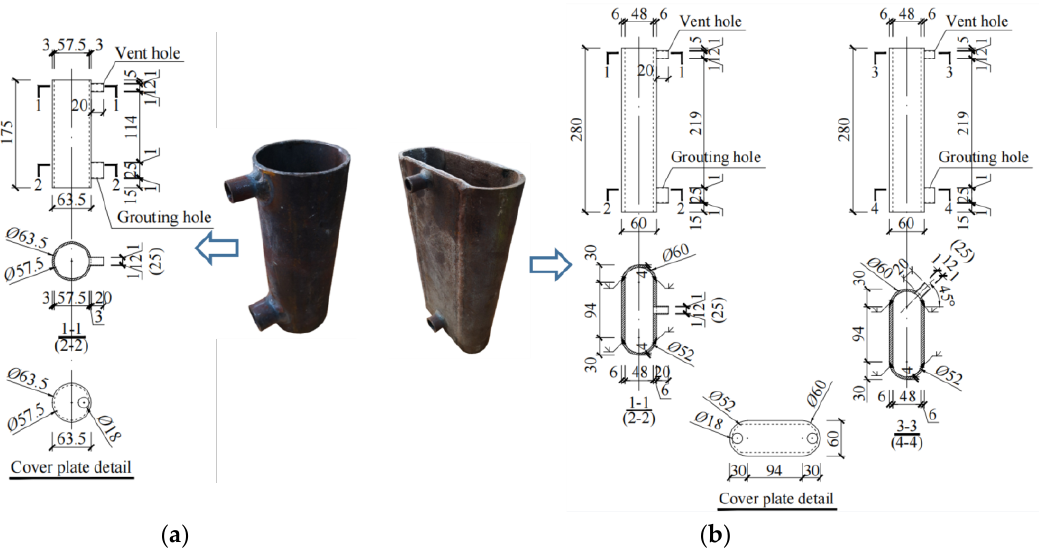
Figure 3. Details of APC sleeves: ( a ) type-I sleeve; and ( b ) type-II sleeve.